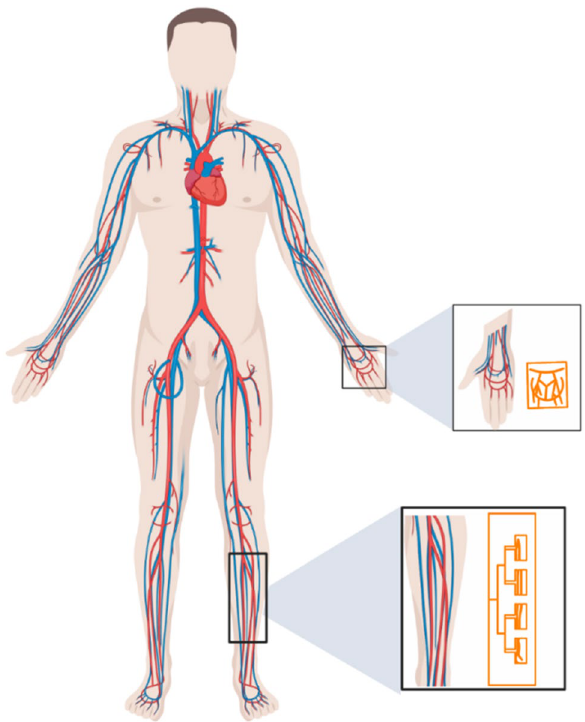
Figure 2. The sensors are biologically inspired by the vasculature anatomic of the targeted blood vessels. The EM hand sensor is a multi-band slot antenna. The top sensing layer is composed of slots following the main arteries and veins of the hand. The EM leg sensor is a microstrip patch quasi-antenna-array. The radiating slots are inspired by the shape of the arteries and veins in a human lower